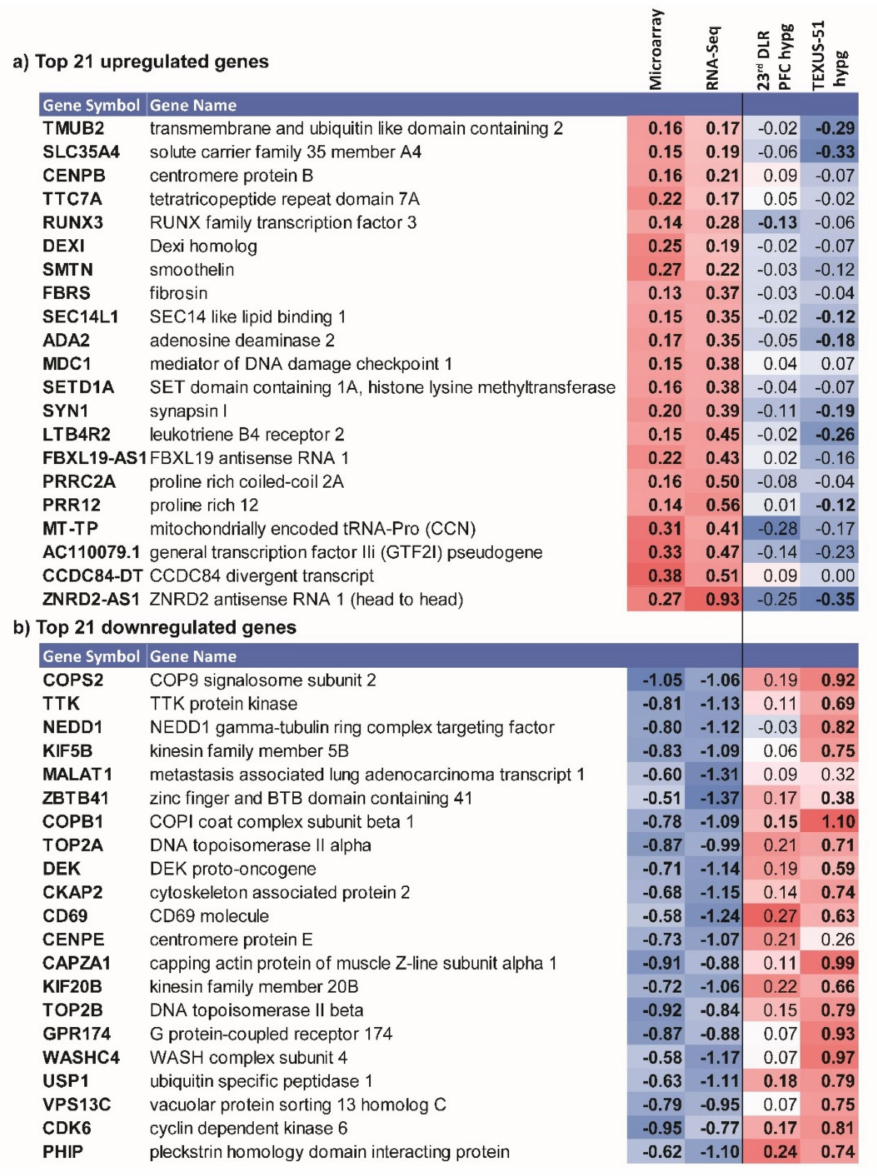
Figure 8. Overlapping genes from Supplementary Figure S3. ( a ) The 21 genes that are significantly upregulated for the microarray and the RNA-Seq data sets are listed. Additionally, the fold changes from two previous short-term hypergravity sets, 23rd DLR PFC hypg and TEXUS-51 hypg, are dis- played. Significant fold changes are printed in bold. ( b ) The analysis from ( a ) for the 21 significantly downregulated genes with highest average fold changes for both data